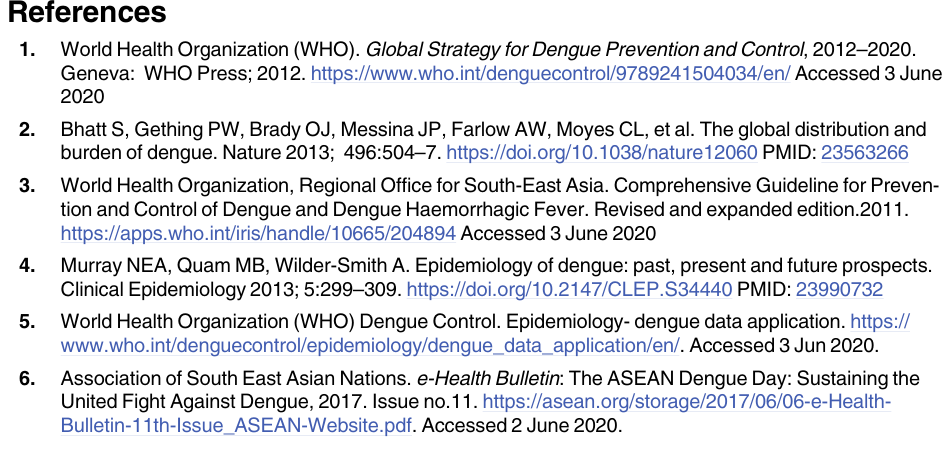
S3 Table. Sensitivity analysis with reclassification of dengue